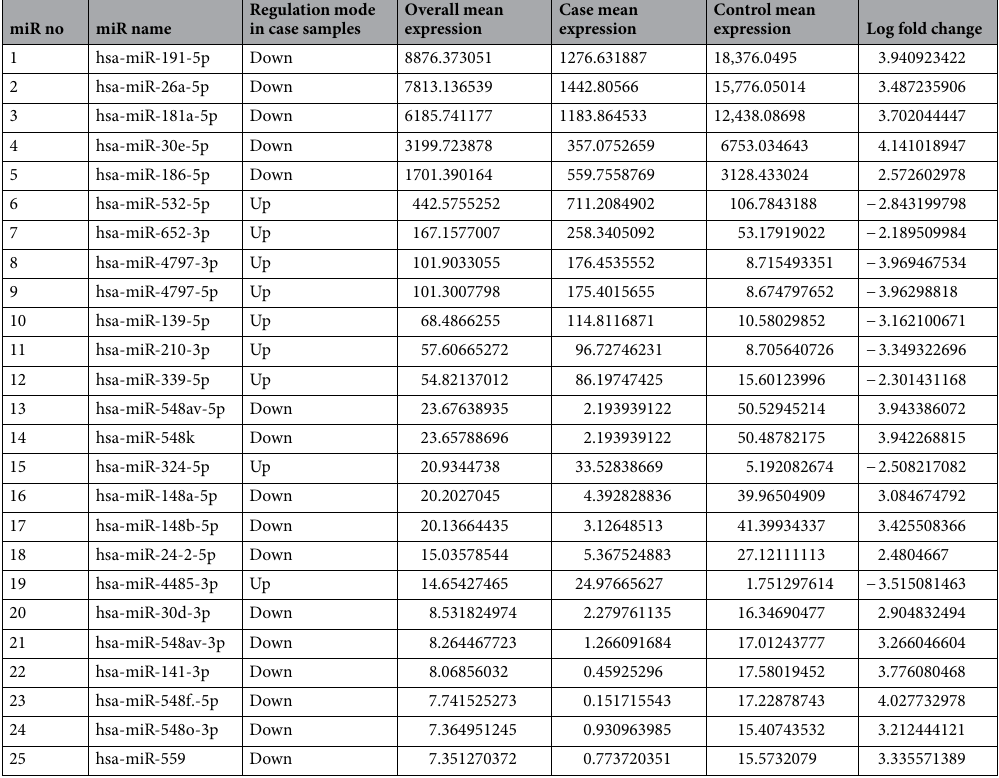
Table 2. Twenty-five proposed miRs in deep sequencing using four differential expression analyses.